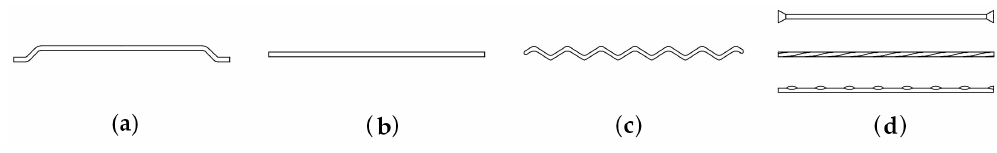
Figure 2. Most common steel fibers: ( a ) Hooked; ( b ) Straight; ( c ) Crimped; and ( d ) Other types.